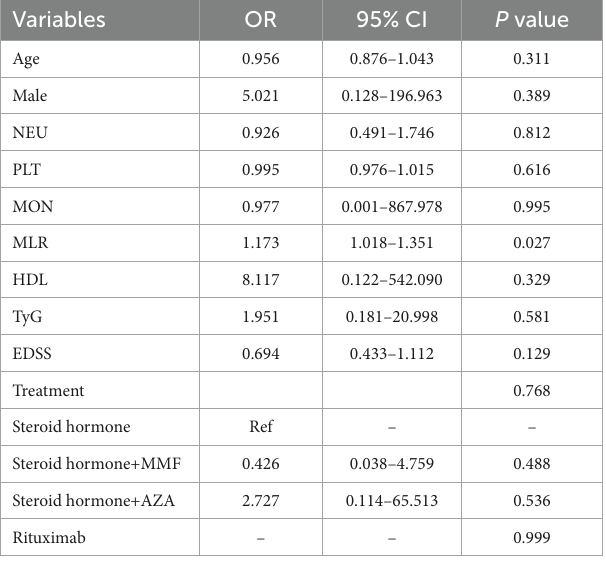
TABLE 4 Binary logistic regression analysis for risk factors for